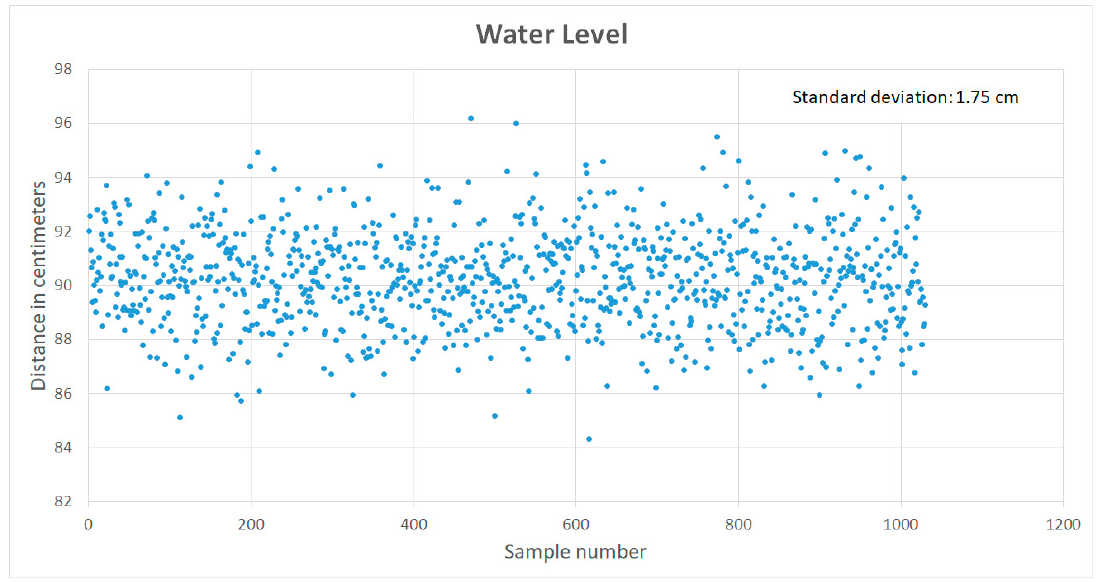
Figure 20. Retrieved data from a deployed node.